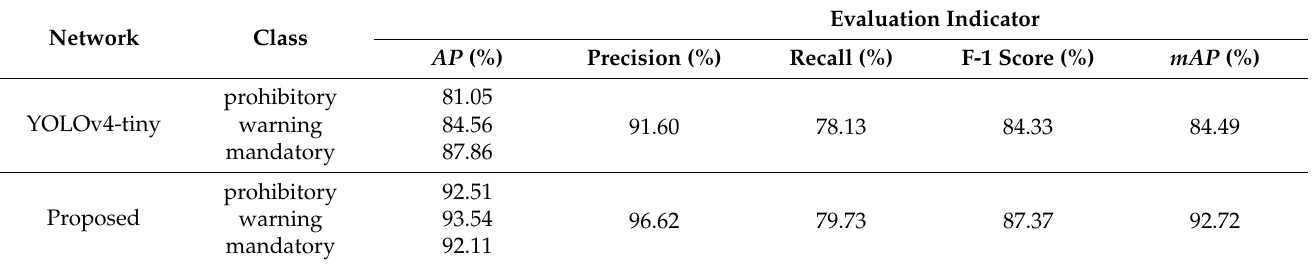
Table 4. Performance of the improved YOLOv4-tiny ablation results for the CCTSDB2021